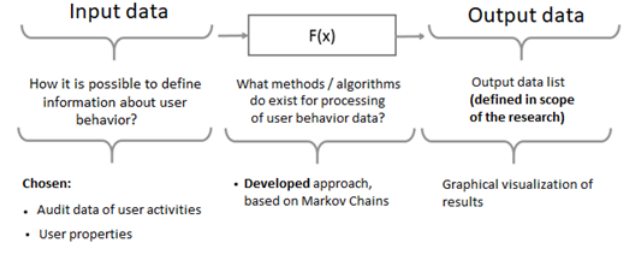
Fig. 3. Depiction of the result of this paper regarding original research question . The main conclusions are the following